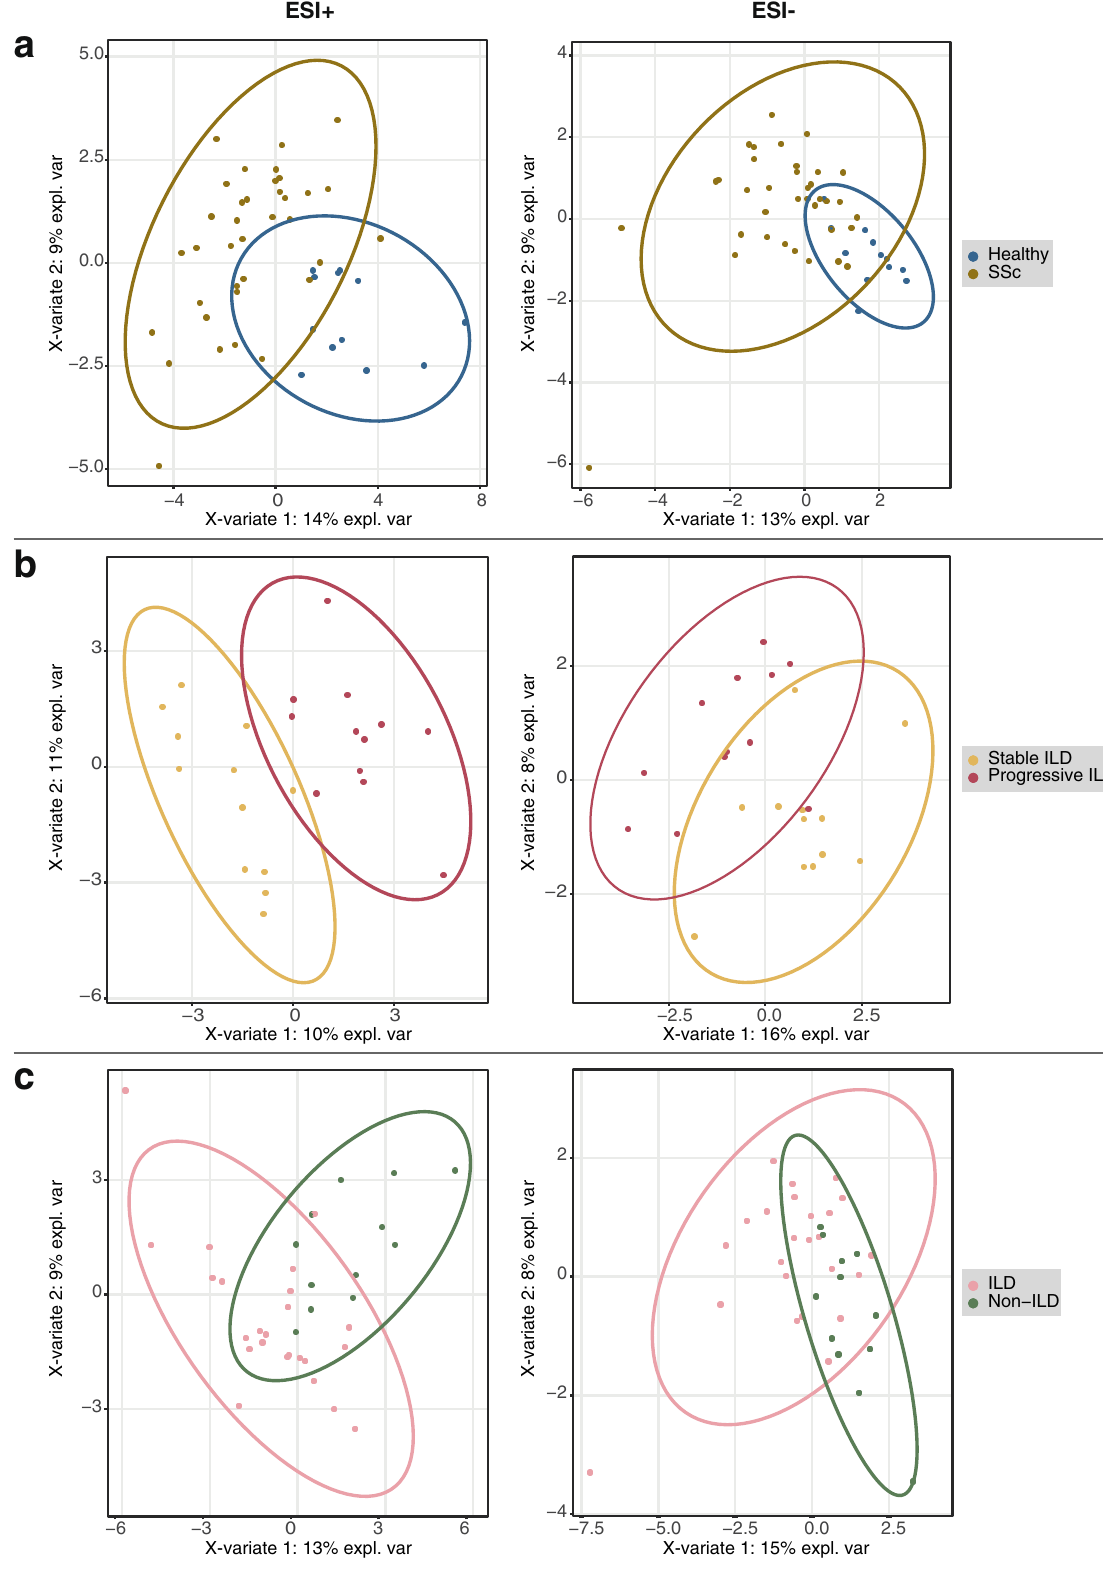
Figure 3. Group-wise PLS-DA analysis of metabolomics data. ESI+/− positive/negative electrospray ionization. ( a ) Healthy (n = 12) versus all SSc (n = 36); ( b ) stable versus progressive SSc-ILD (n = 12 per group); ( c ) all SSc- ILD (n = 24) versus non-ILD SSc (n =